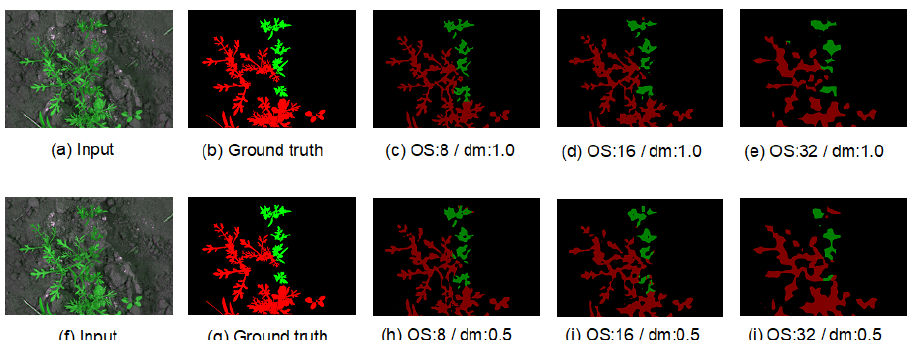
Figure 8. CWFID and weeds dataset qualitative segmentation results. Except for input and ground truth, the labels of each sub-image indicate the optimization that was applied to the model to pro- duce the segmentation [32]. ( a ) Input; ( b ) Ground truth; ( c ) OS:8/dm:1.0; ( d ) OS:16/dm:1.0; ( e )